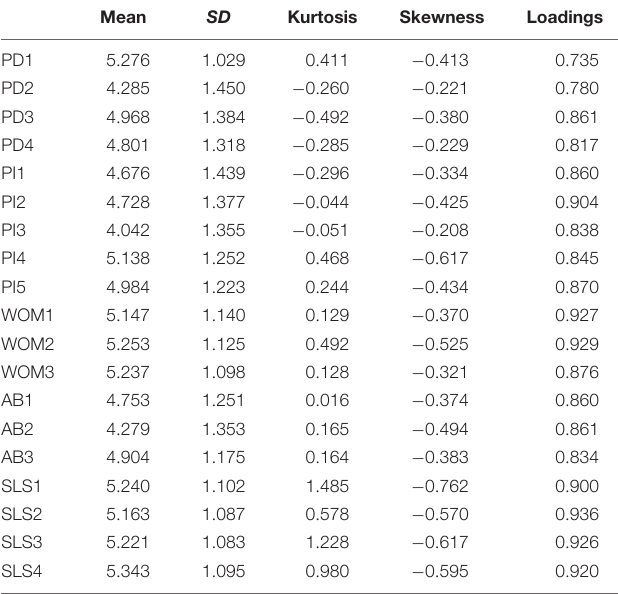
TABLE 3 | Descriptive statistics and factor